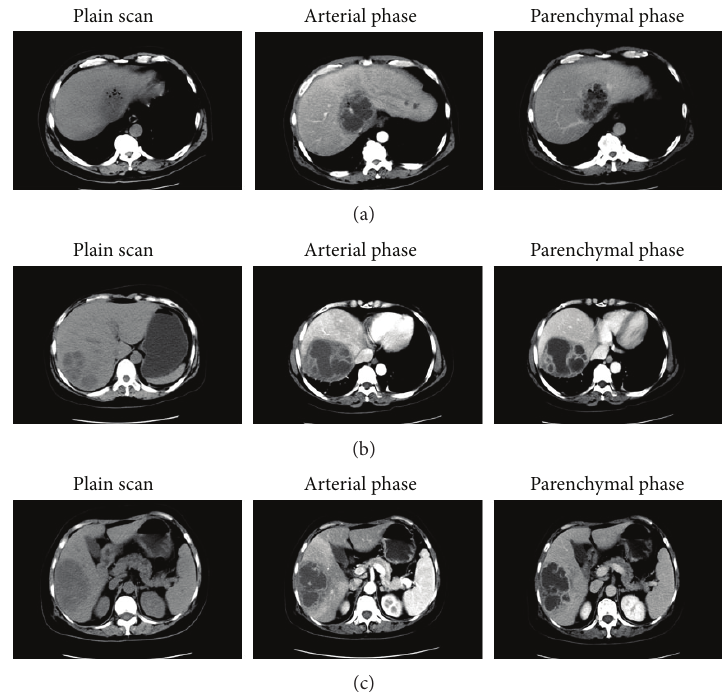
Figure 1: Comparison of abdominal CT images between KLA and Non-KLA. (a) CT images of a 57-year-old male KLA patient with concomitant diabetes mellitus: circular shadow of low and uneven density can be seen in the caudate lobe near the second hepatic portal. With a diameter of 90mm, a shadow of much lower density and gas cavities can be seen in the center of the abscess. During enhanced scanning, the margin and internal septations of abscess show a honeycomb-like structure. Intrahepatic bile ducts show slight dilation. (b) CT images of a 51-year-old female patient with E. coli liver abscess: irregular low-density lesion with a honeycomb-like structure can be seen in the right lobe of the liver. Obvious cystic wall enhancement can be seen during enhanced scanning. There is no stenosis or filling defect of hepatic vessels. (c) CT images of a 65-year-old female patient with Pseudomonas aeruginosa liver abscess: patchy shadow of low-and-even density and clear edge can be seen in the right lobe of the liver. By enhanced CT scan, the peripheral enhancement is more dramatic than the nonperipheral enhancement.Septationisvisibleinsidetheabscess,andhepaticbloodvesselsareevenlydistributed.KLA: Klebsiellapneumoniae liverabscess; Non-KLA: non-Klebsiella pneumonia -induced pyogenic liver